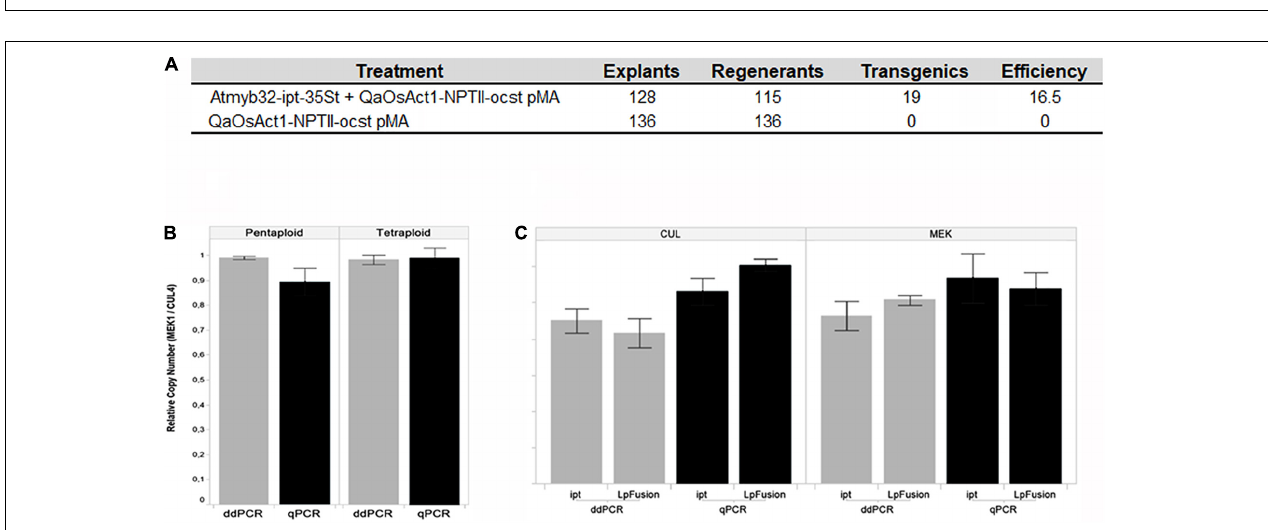
FIGURE 2 | Use of reporter genes for the development of a biolistic transformation protocol. (A) Bombarded calli expressing green fluorescent protein (GFP), observed on a confocal microscope. (B–D) Bombarded calli expressing GUS osmopretreated with mannitol [ (B) 32g/l, (C) 64g/l, and (D) 96g/l]. (E) Association between the concentration of mannitol, number of transient events, and frequency of regenerants. Source: Schrauf (2009).